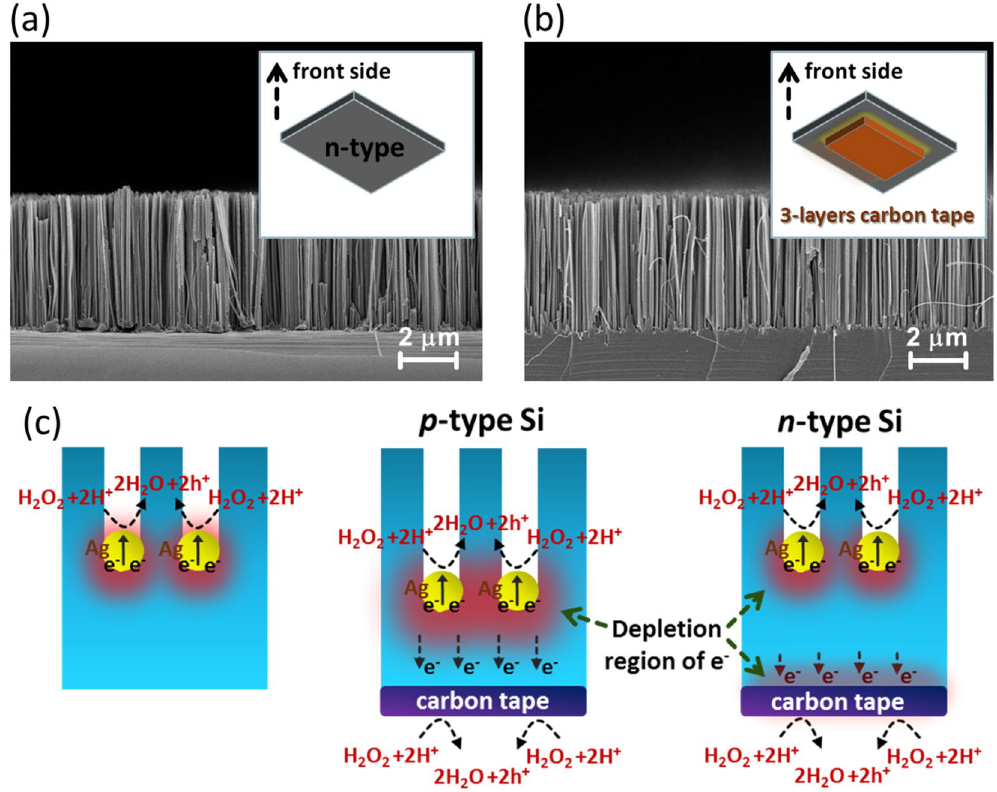
Figure 5. Cross-sectional SEM images of aligned Si nanowire arrays obtained from catalytic etching of n-type Si: ( a ) conventional MaCE and ( b ) back-substrate assisted MaCE with three-layer conductive carbon tape as back substrates. ( c ) Schematic illustrations for the distinct formation mechanisms of MaCE process: Si substrates (p-type or n-type) without conductive back substrates, Si substrates (p-type) and Si substrates (n-type) with conductive back